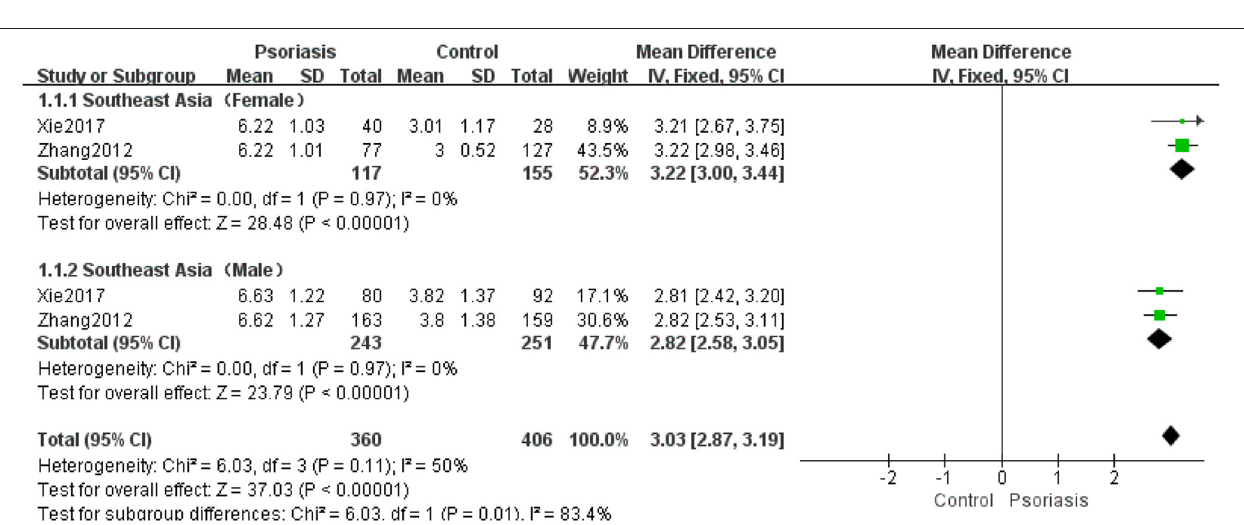
positive correlation between SUA levels and erythrodermic psoriasis, similar to arthritic psoriasis (33). Elevated